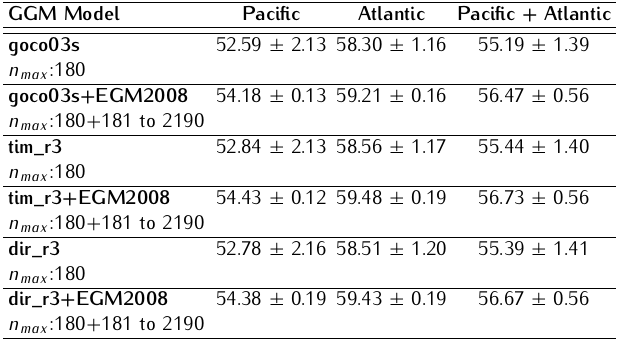
Table 2. W 0 values for Pacific, Atlantic, and Pacific + Atlantic tide gauges with 19 years of water level data with GGMs expanded to degree 180 and 2190 (add 62636800.00 m 2 /s 2 to values in table).